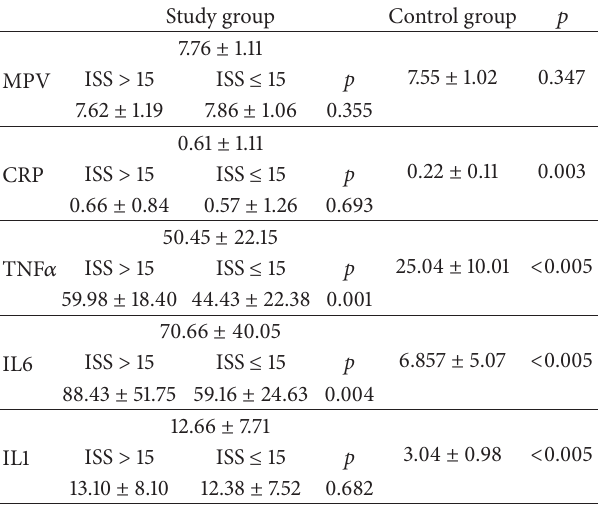
Table 4: Comparison of biochemical markers within between study groups and